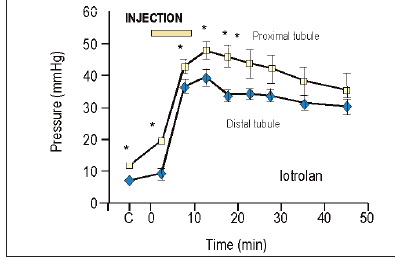
Fig. 1. Medullary hypoxia induced by CM com- pared with Ringer’s solution. Reduction in pO 2 is greatest for iotrolan (iso-osmolal non-ionic dimer) followed by ioxaglate (low-osmolal ionic dimer). Iopromide (low-osmolal monomer) had the least effect of the CM. Data from Liss et al. 36